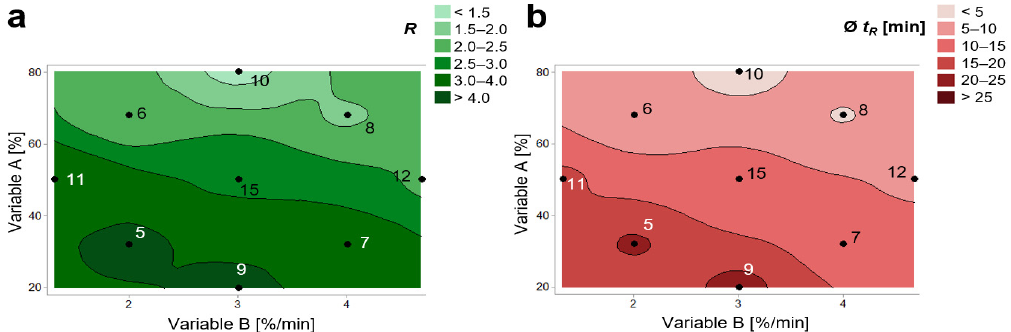
Figure 2. Contour plots visualizing the effects of variables A (starting concentration of eluent B) and variable B (slope of gradient) on chromatographic resolution R and mean retention time Ø t R of guggulsterones. Numbers (5–12 and 15) demonstrate the individual experiments (described in detail in Table S1). The level conditions of experiment #8 exhibited the required chromatographic resolution R < 1.5 and a rapid run time with Ø t R < 5 min. ( a ) Effect of variables A and B on the chromatographic resolution R between ( E )-guggulsterone and ( Z )-guggulsterone. ( b ) Effect of variables A and B on the averaged retention time Ø t R of ( E )-guggulsterone and ( Z